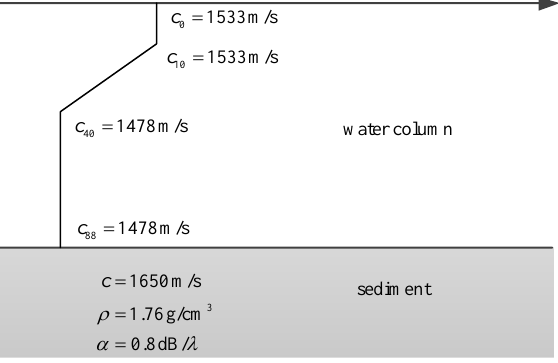
Figure 1. Typical shallow-ocean sound field environment for simulation.